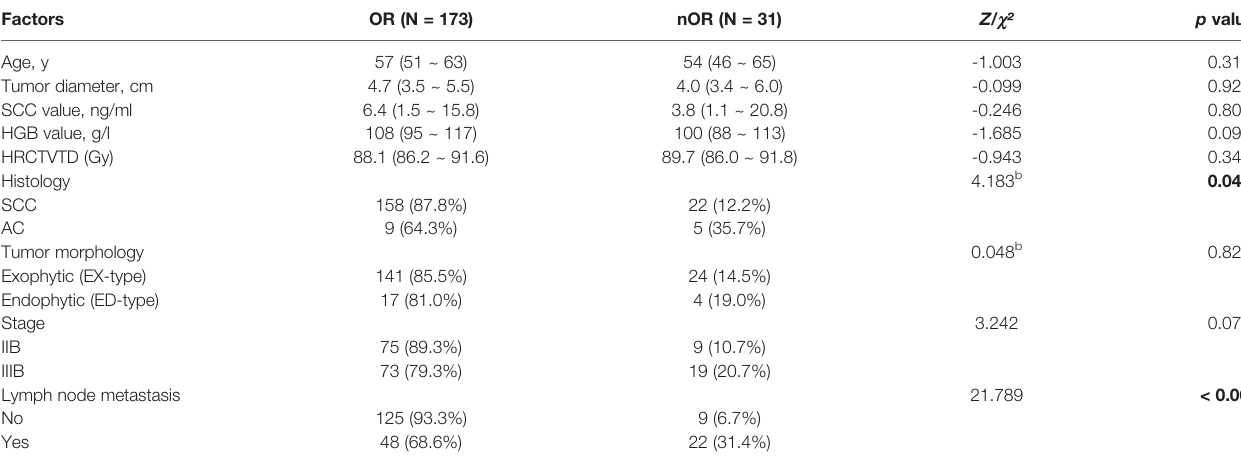
TABLE 2 | Univariate analysis of short-term ef fi cacy in patients with LACC.